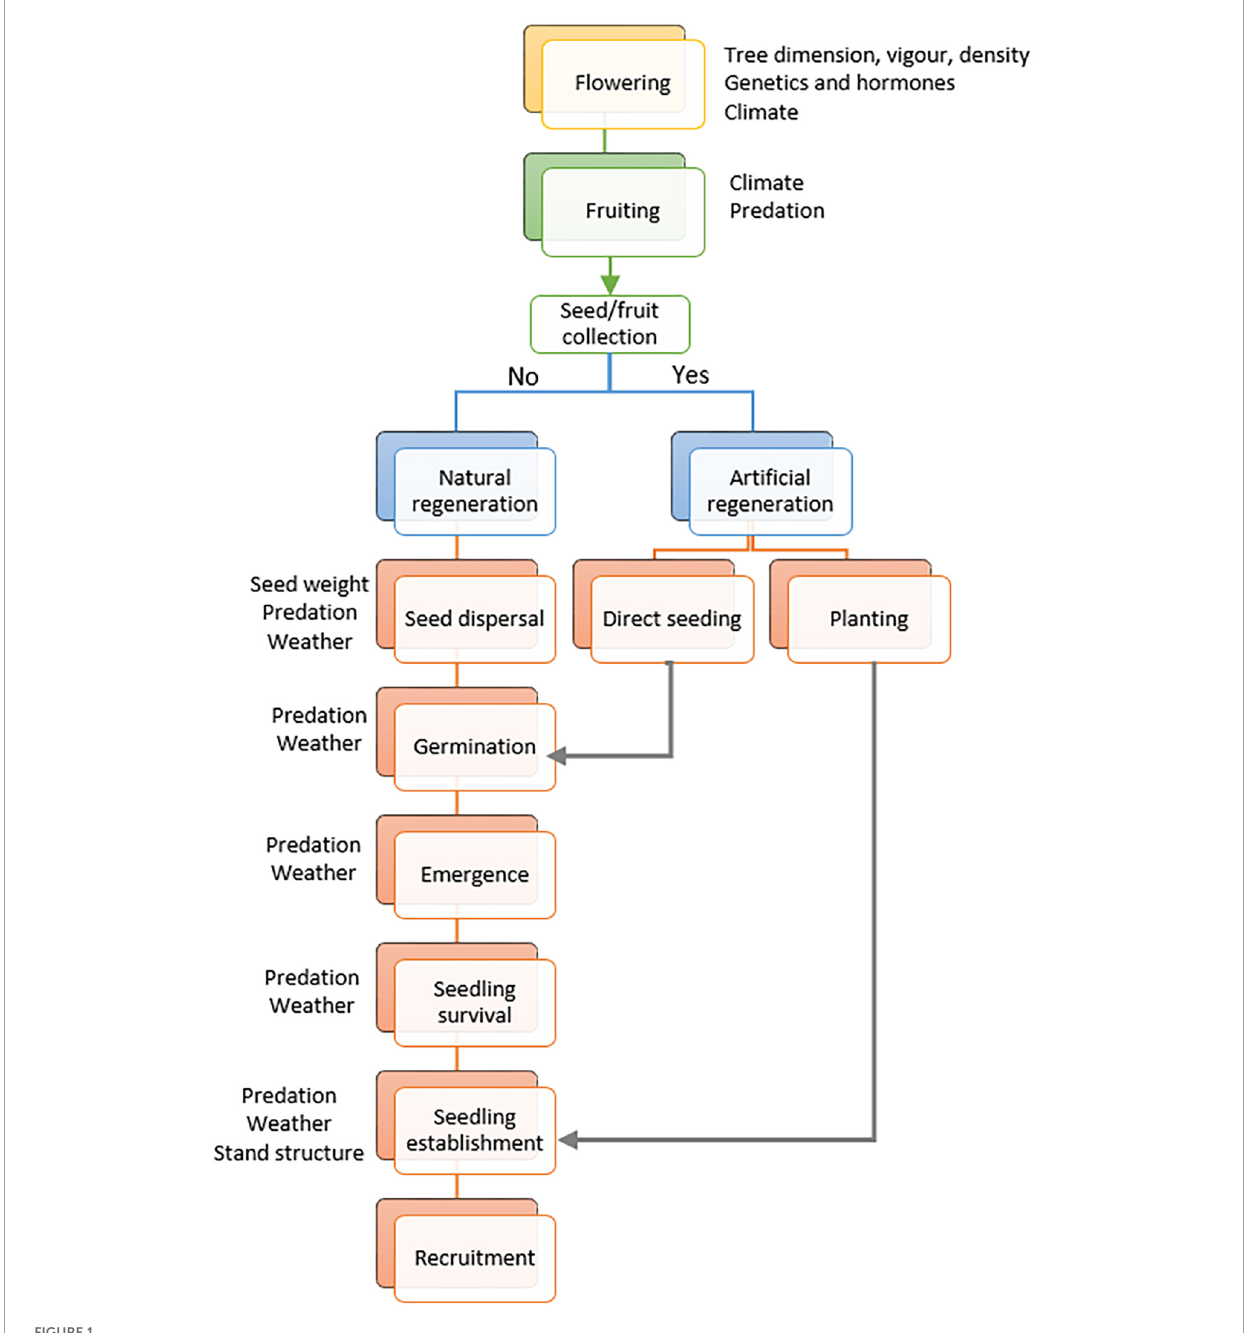
FIGURE1 Schematic representation of the regeneration processes and factors.